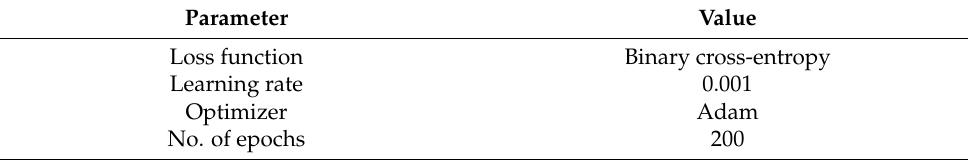
Table 2. ANN model